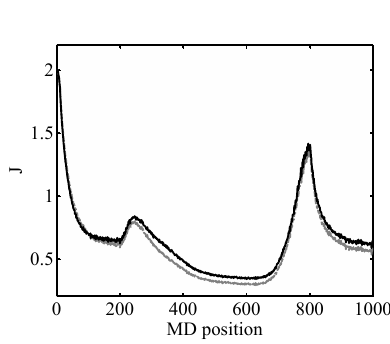
Figure 9: Actuating energies and cumulative sum of saturating actuators. On top, results with- out automated tuning of spatial controller. On bottom, results with automated tuning of spatial controller. The dotted line is for Actuator 1, dashed line for Actuator 2 and solid line for Actuator